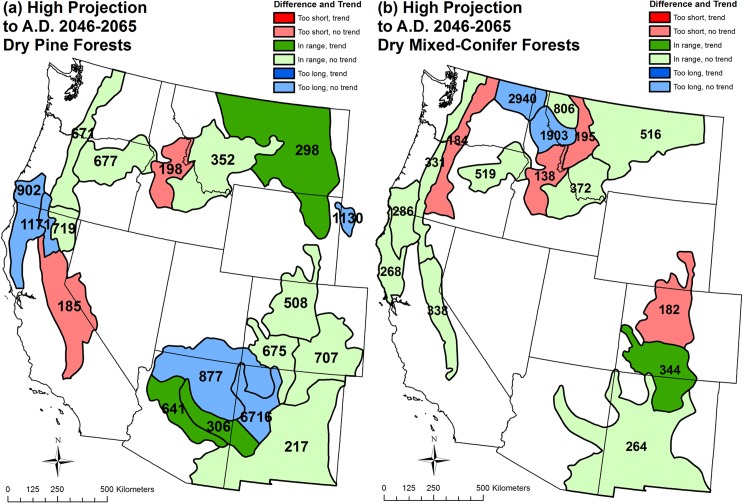
High projection (to A.D. 2046–2065) of differences relative to the historical range of high-severity fire rotations, given 1984–2012 trends, and projected fire rotations for high-severity fire in (a) dry pine forests and (b) dry mixed-conifer forests by analysis region.Several analysis regions are omitted, because the high projections by Yue et al. [42] were not possible for those areas. See Fig 3 for an explanation of figure contents.